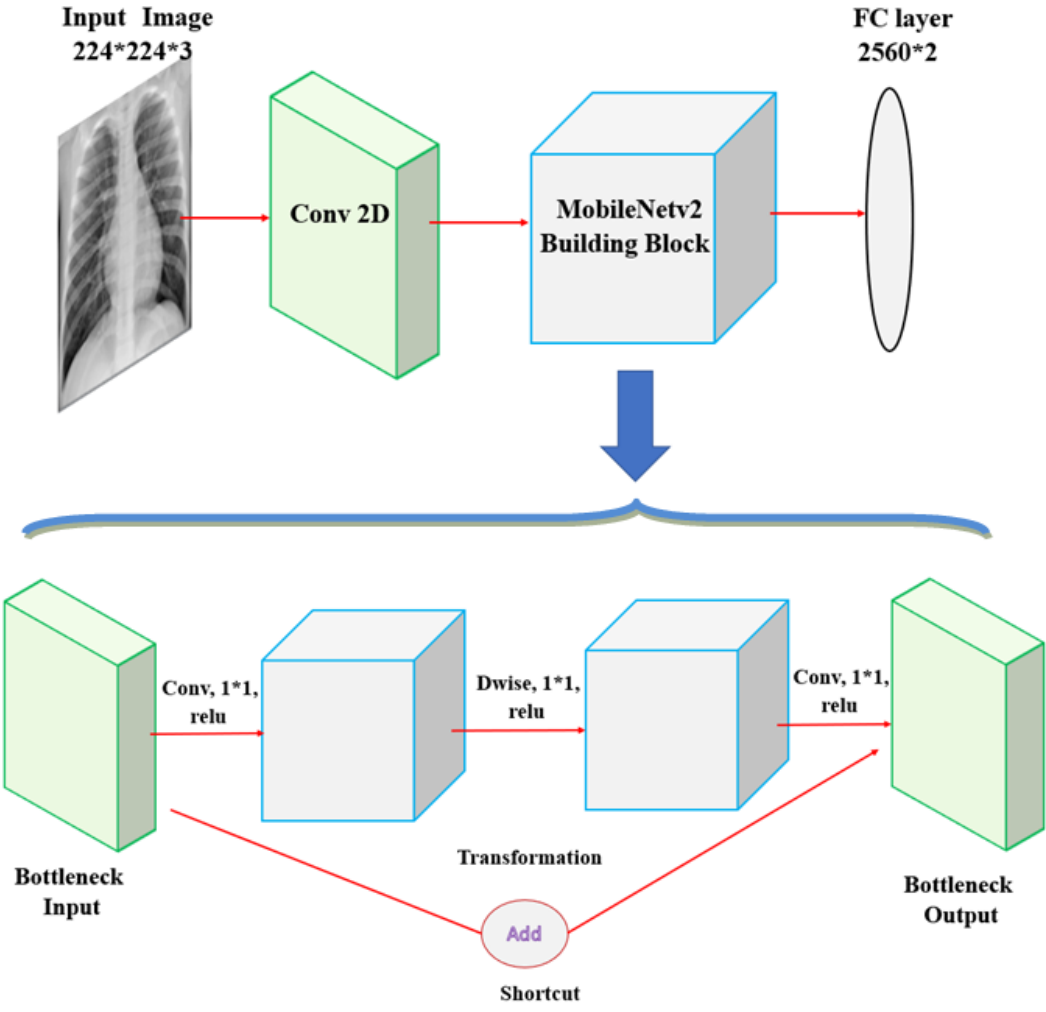
Figure A5. MobileNetV2 architecture with the MobileNetv2 building block comprising bottlenecks and depth-wise separable